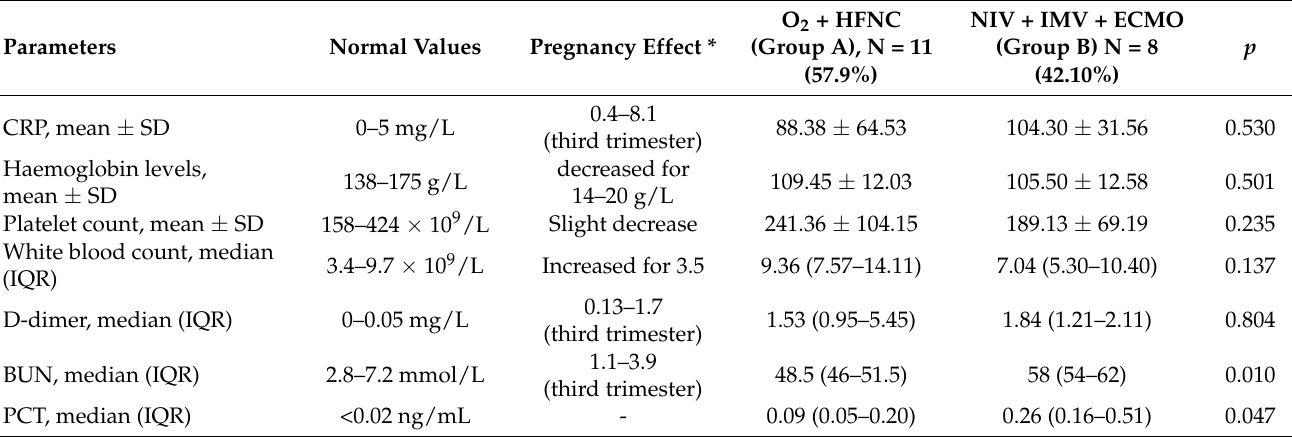
Table 3. Laboratory parameters of all treated pregnant/postpartum women.